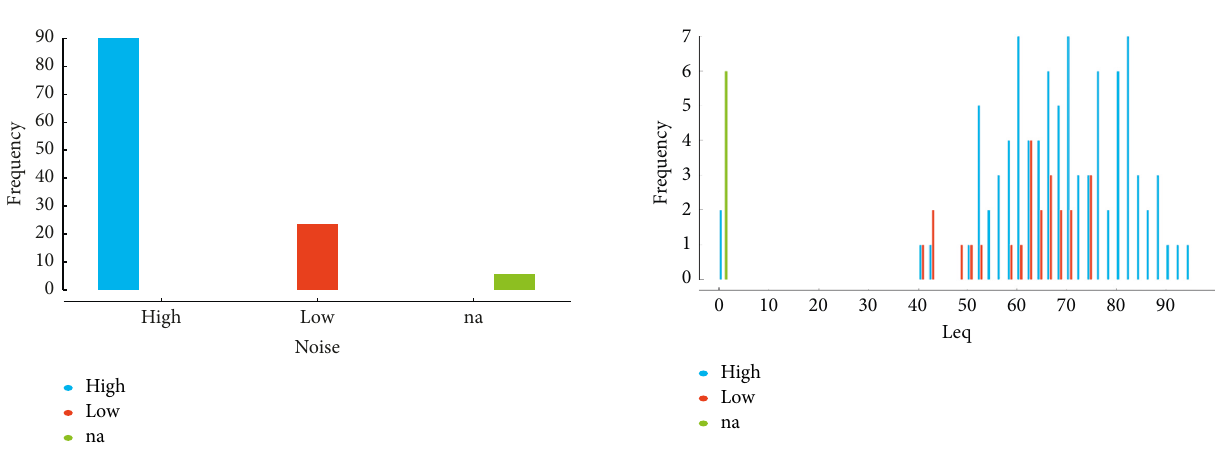
Figure 4: Noise feature distribution in dataset generated by Orange tool with respect to noise feature.